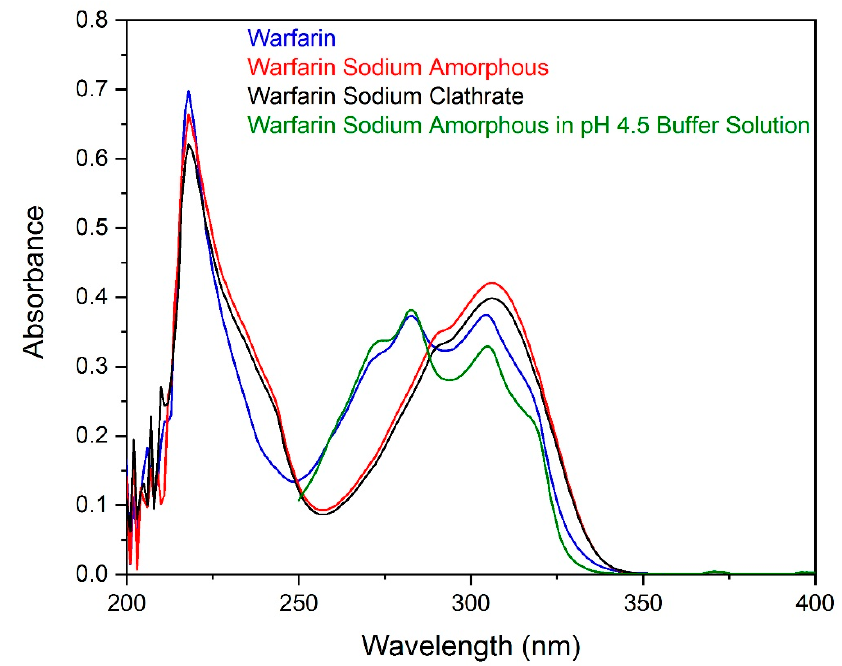
Figure 8. UV absorption spectra of aqueous solutions of warfarin sodium amorphous API, warfarin sodium clathrate API, warfarin API, and warfarin sodium amorphous supernatant in a buffer solution (pH = 4.5).